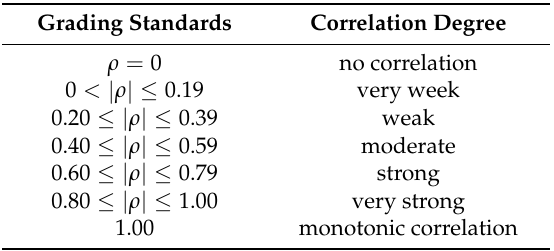
Table 2. Grading table of Spearman correlation coefficient (